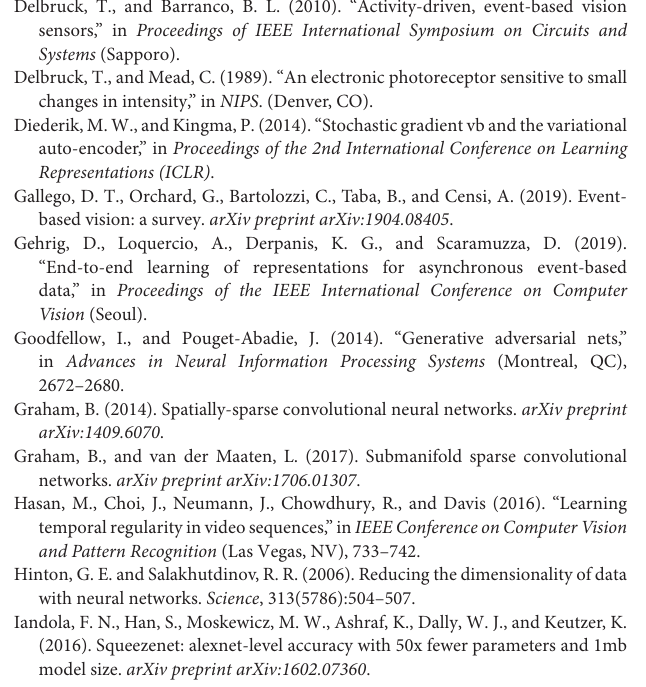
Table 7 ), more suitable for real-time hardware implementations with less computation